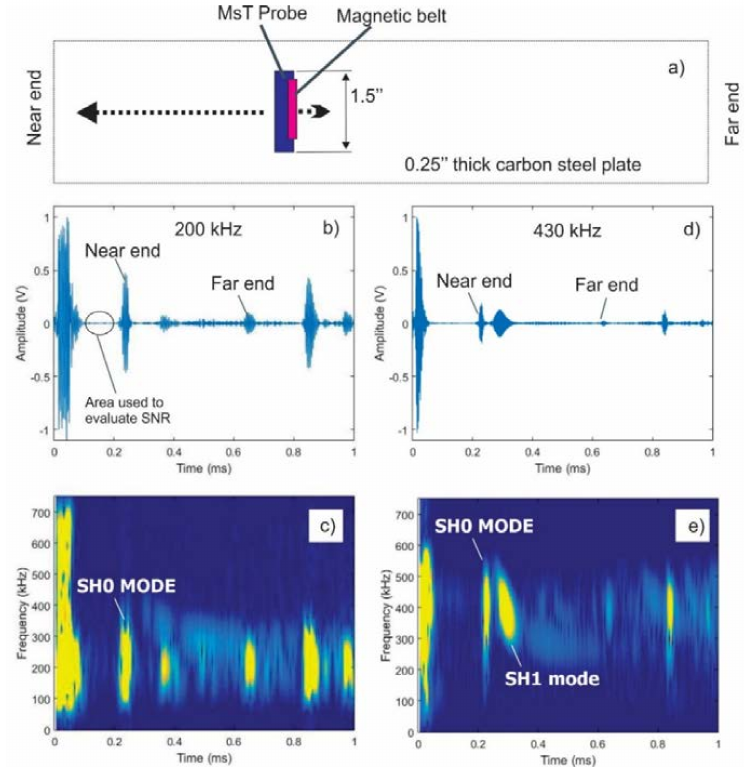
Figure 12. Demonstration of unidirectional probe operation at 200-kHz and 430-kHz center frequencies on a 0.25-inch thick carbon steel plate: ( a ) test arrangement using 1.5-inch wide MsT transducer, ( b ) 200-kHz data, ( d ) 430-kHz data. The spectrograms of signals in panels ( b , d ) are shown in ( c , e